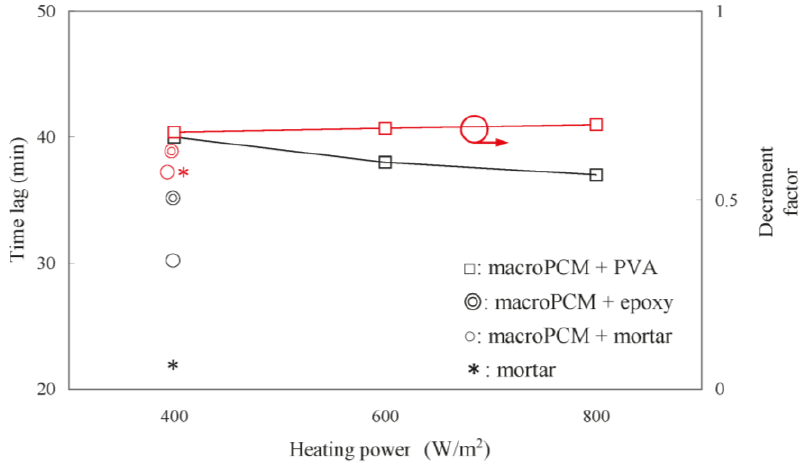
Figure 9. Time lag and decrement factor of experimental modules in relation to different levels of heating power.